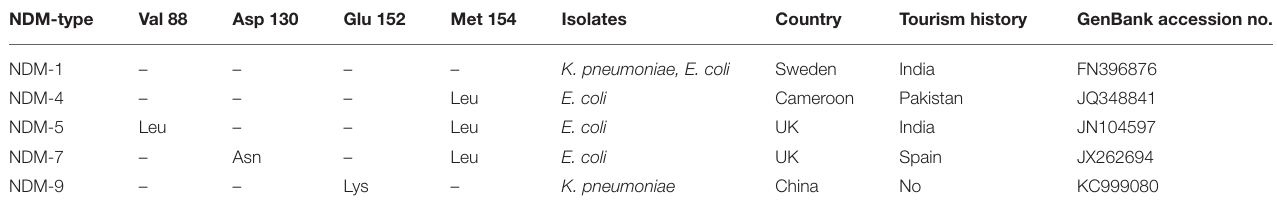
TABLE 1 | Amino acid substitutions of initially reported NDM